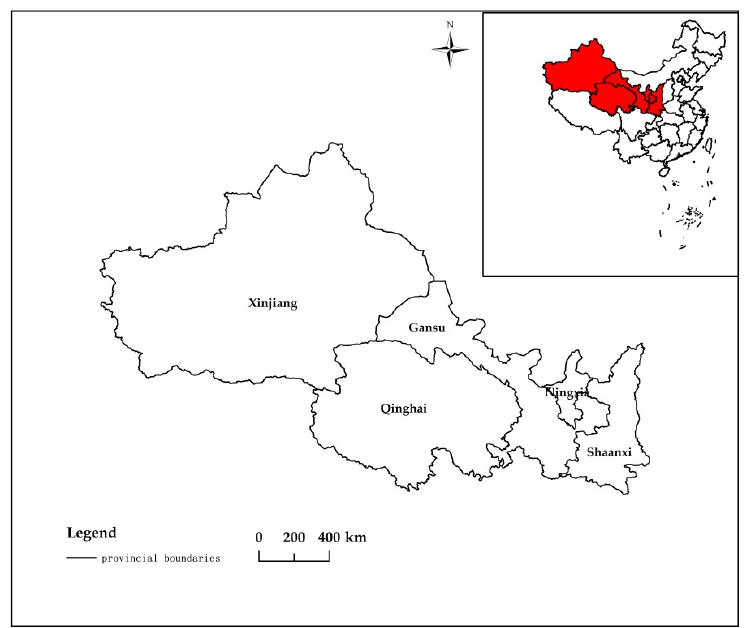
Figure 1. Schematic diagram of the specific locations of the study objects.